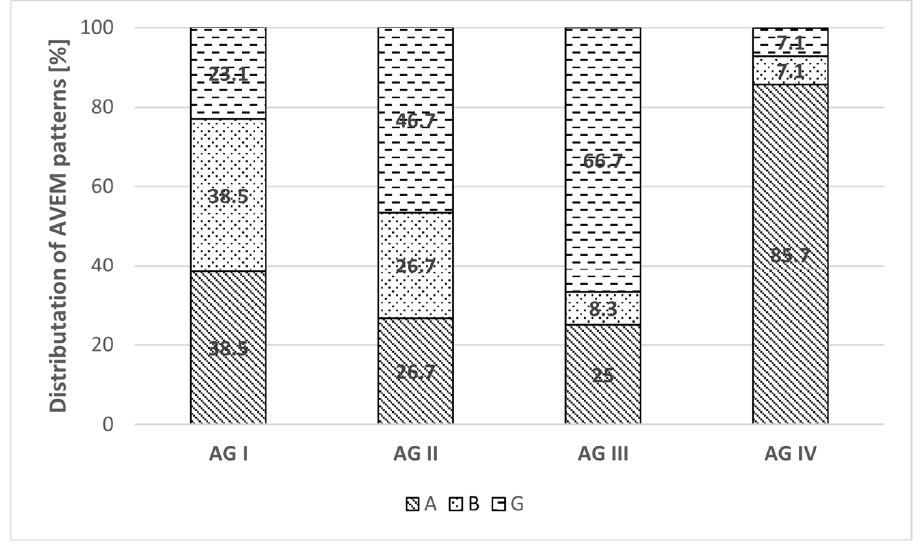
Figure 2. Allocation of AVEM patterns A, B and G within age groups.